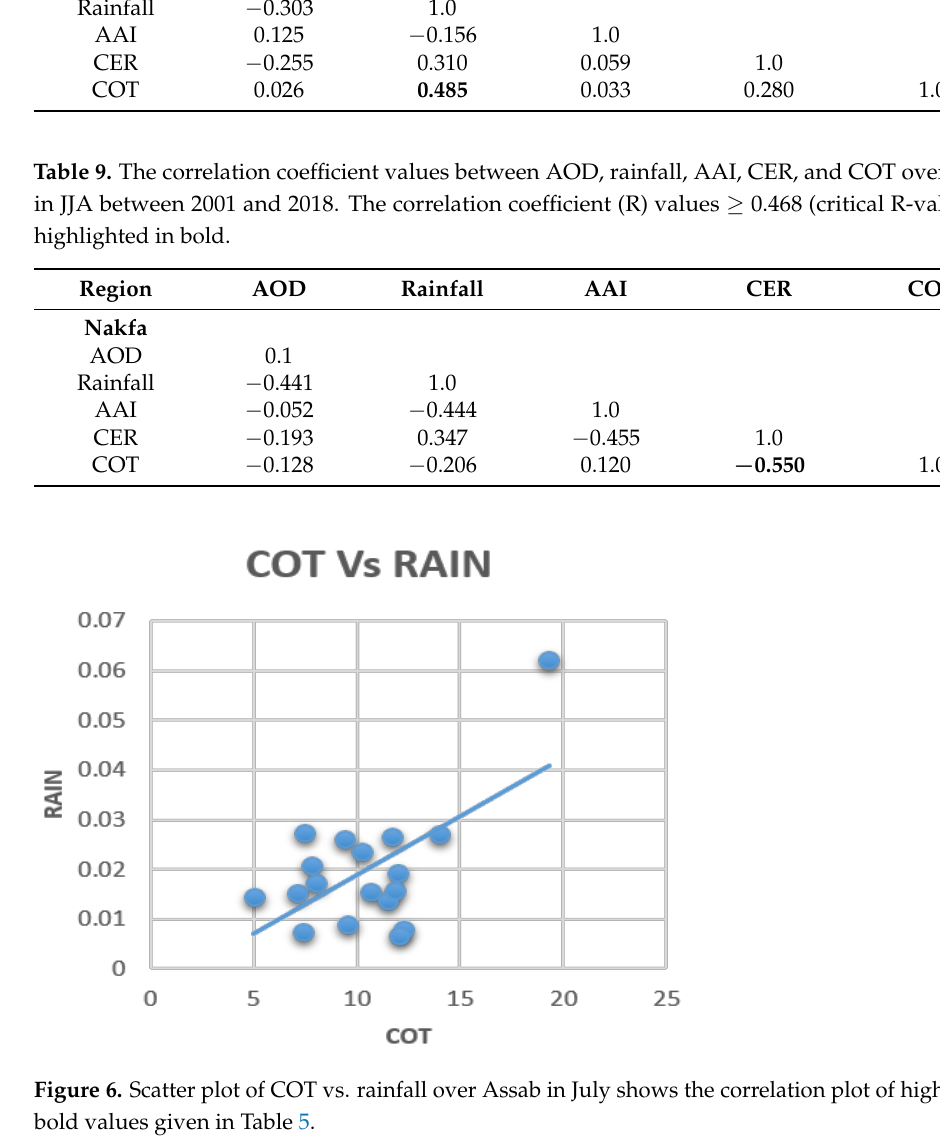
1.0 Table 7. The correlation coefficient values between AOD, rainfall, AAI, CER, and COT over As- mara in JJA between 2001 and 2018. The correlation coefficient (R) value ≥ 0.468 (critical R−value) is highlighted in bold. Region